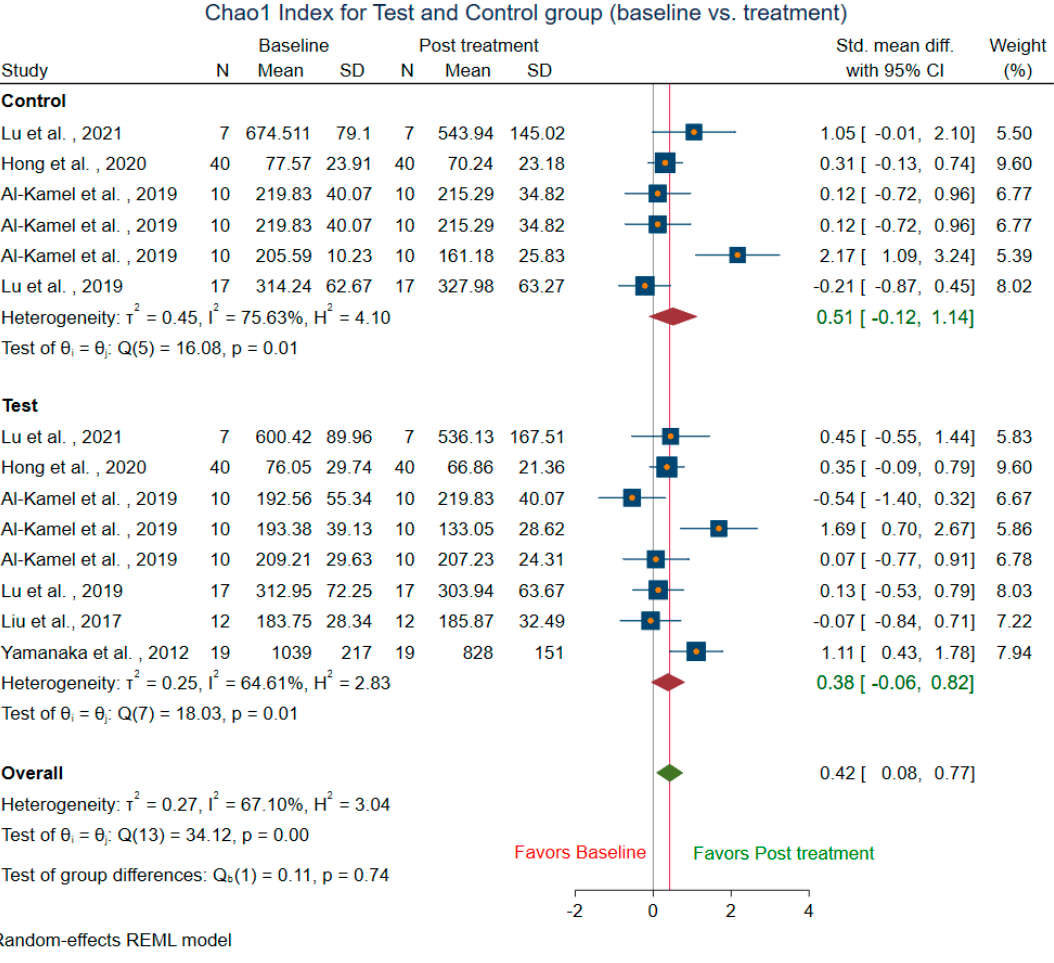
Figure 6. Subgroup meta-analysis of Chao1 index based on test subgroup (baseline vs. post-treatment) and control subgroup (baseline vs. post-treatment).